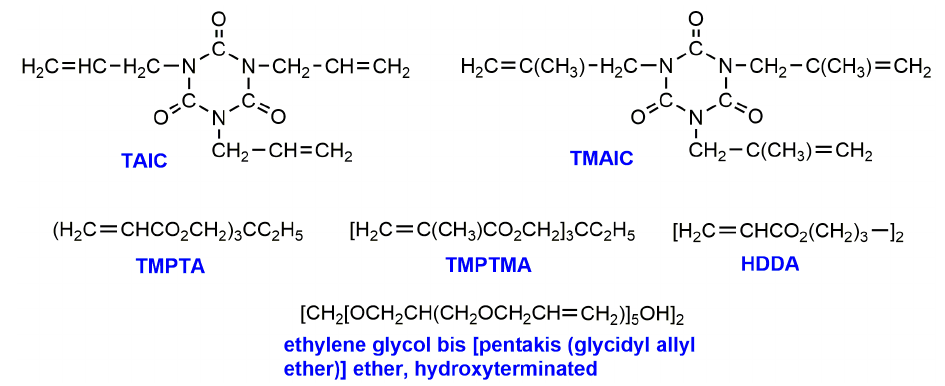
Figure 2. Multifunctional crosslinking agents applied in radiation-induced crosslinking [30]. (Adapted with permission from Elsevier, 2005).